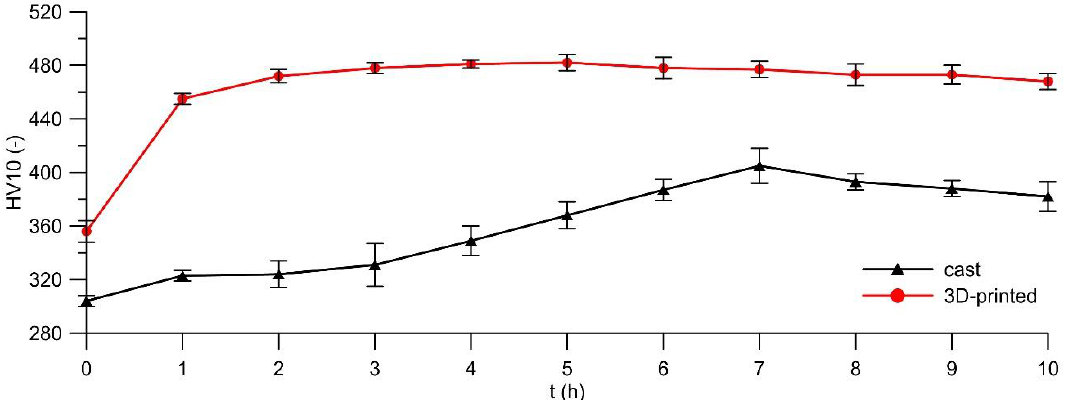
Figure 8. Time hardness evolution during annealing (cast — 800 °C; 3D-printed — 900 °C). Figure 9 indicates the microstructural changes during annealing at different temper-